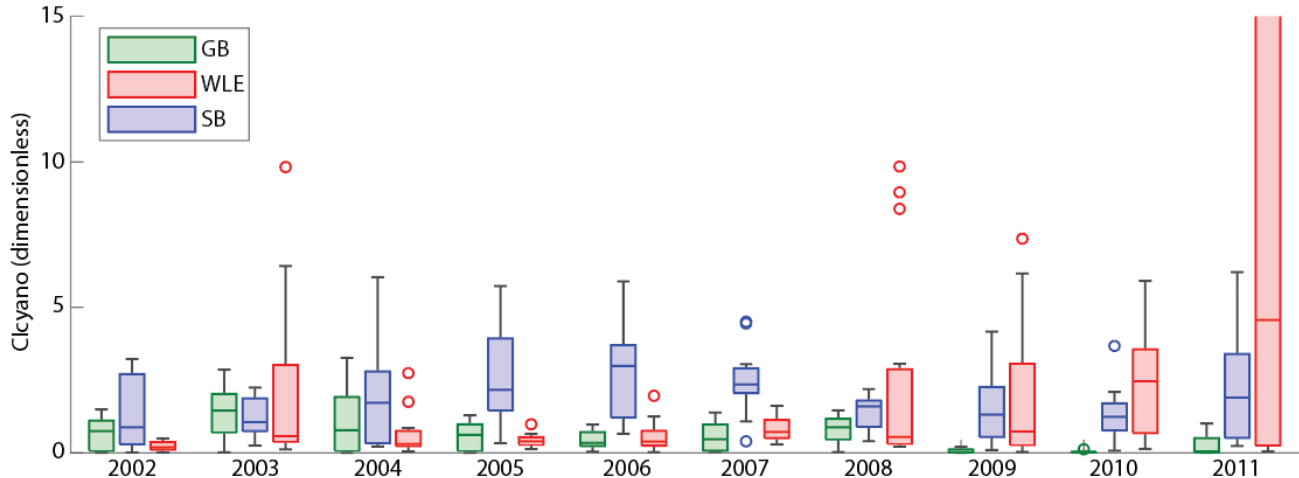
Figure 7. Timeseries for the annual CI cyano for each of the three basins: Green Bay (Green), western Lake Erie (red), and Saginaw Bay (blue). The annual CI cyano presented here is a cumulative sum of the maximum 10-day composite of the CI cyano for each respective basin, from each year. Three basins were presented for comparative purposes. The graph was cropped at 15 to remove outliers from Lake Erie in 2010 and 2011, to show variations in the plot.